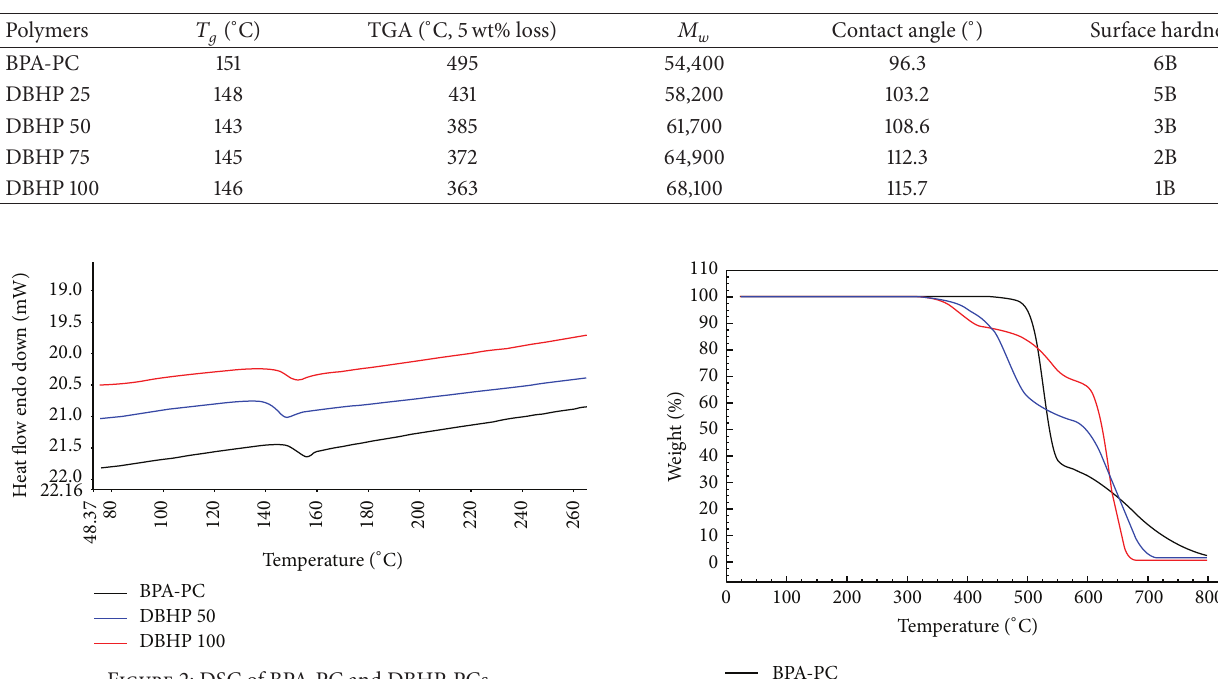
Table 1: Properties of polycarbonates.